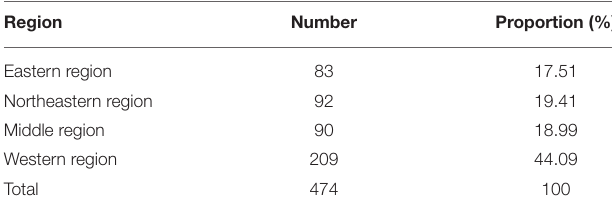
TABLE 7 | The distribution of nature reserves in China